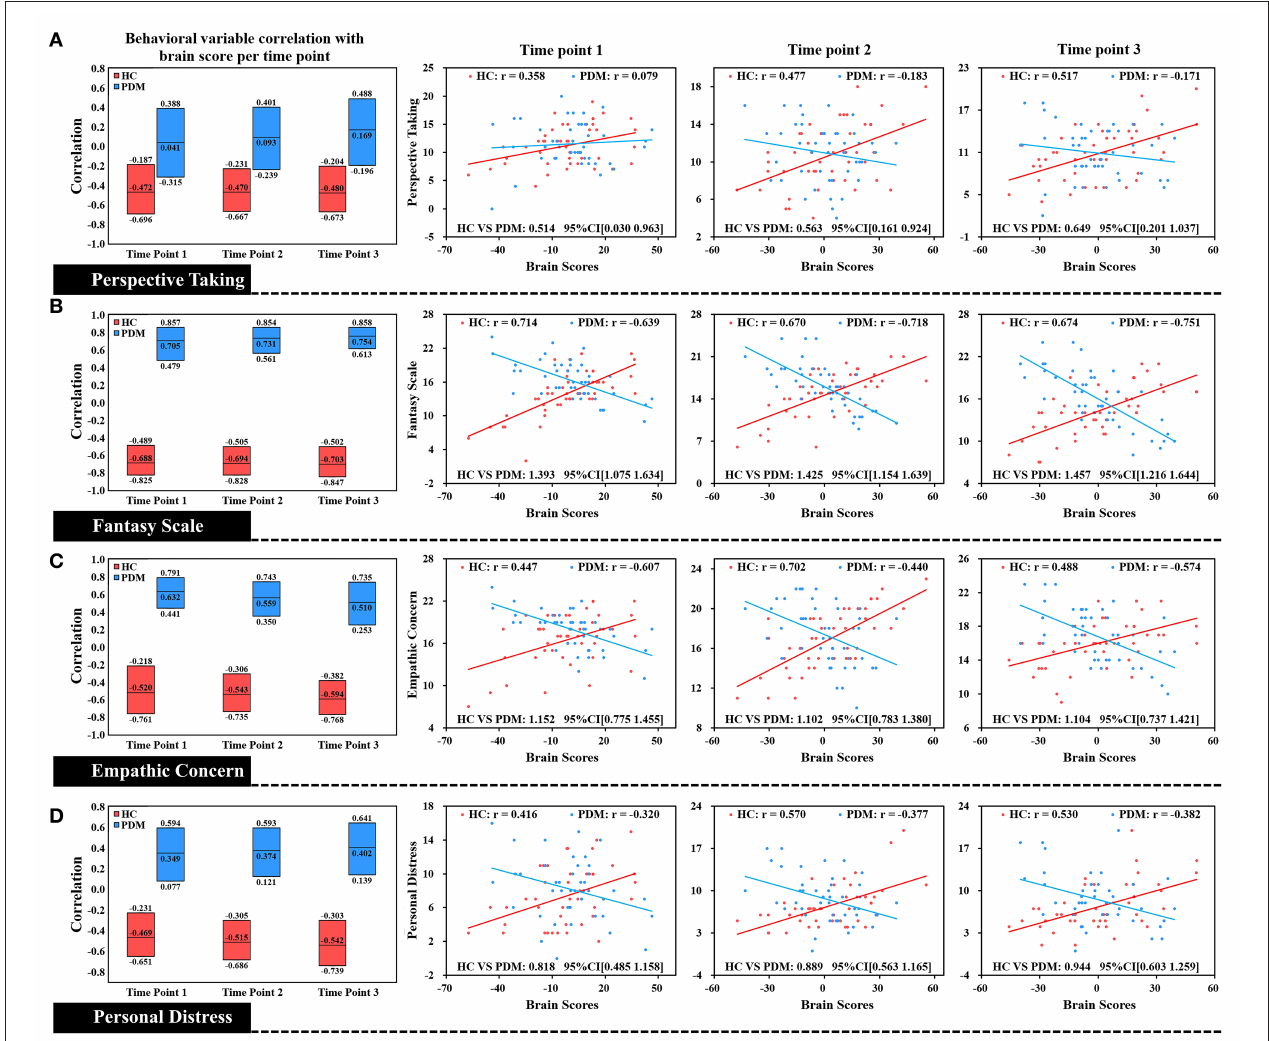
FIGURE 2 | Correlation of each level of trait empathy with brain scores of LV 1. In the box plot, the middle line of the box was the original correlation between empathy and brain score in the same phase, and the boundary of the box was the 95% CI of the trait empathy correlation with brain scores based on the use of 5,000 bootstraps. The original correlation between empathy and brain scores is shown by the scatter plot. There was a significant difference between HC and PDM in different dimensions of trait empathy in correlation with brain scores at the periovulatory, luteal, and menstruation phases through the effect-size analysis. There were no significant correlation changes in both groups during the three phases. HC, red; PDM,